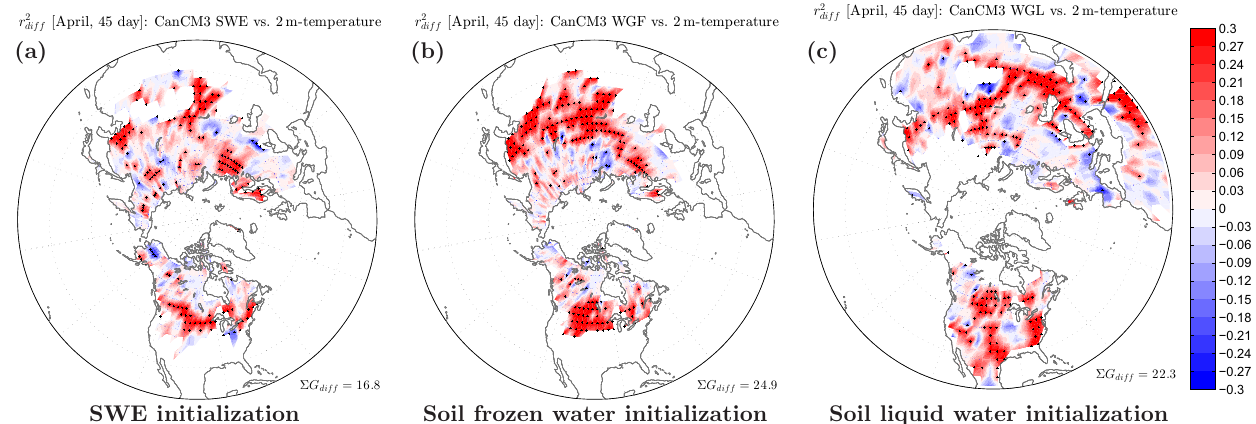
Figure 12. Impact on the square of the anomaly correlation coefficient of initialization of (a) SWE, (b) frozen soil water, and (c) liquid soil water on springtime forecasts of land-surface temperature at 45-day lead. Red colours indicate increase and blue colours decrease of the potential predictability (an idealized model based estimate of potential forecast skill). Based on Ambadan et al. (2015).